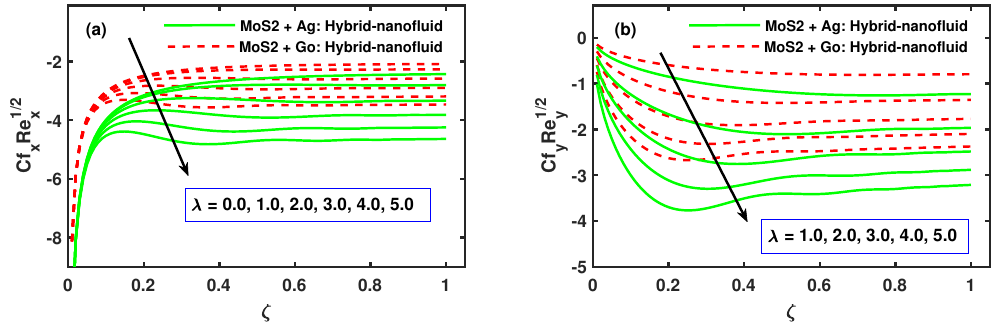
Figure 10. Fluctuation of Cf x Re 1/2 x and Cf y Re 1/2 y along with λ (rotating parameter).